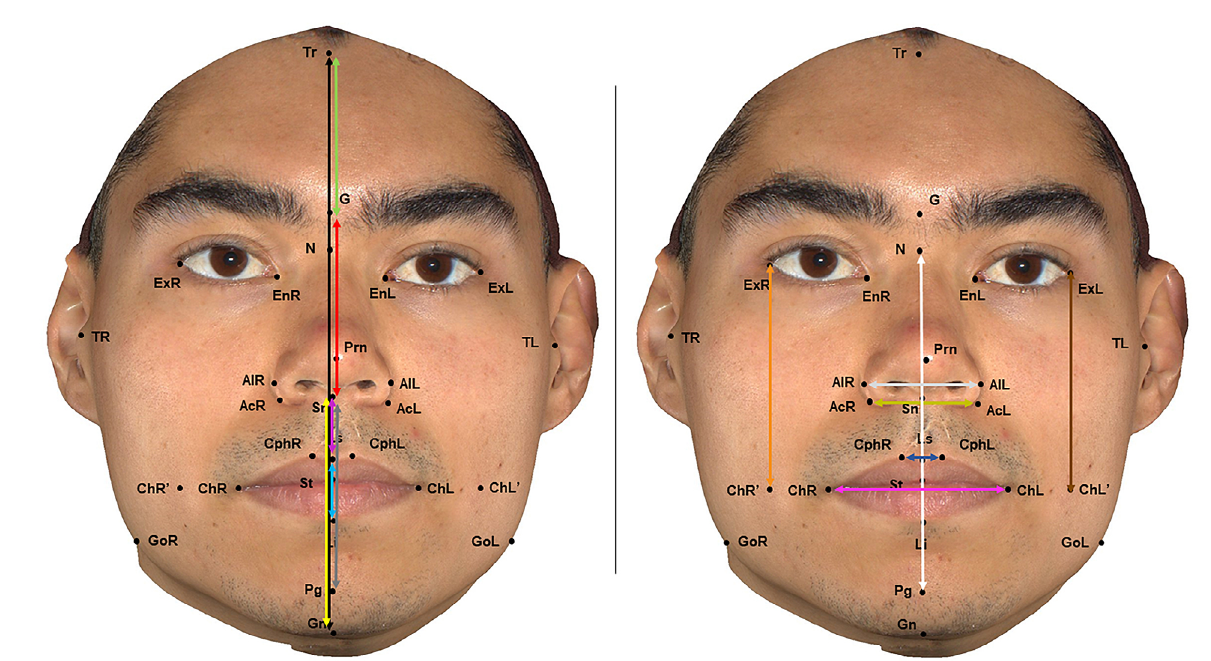
Figure 2- Linear measures obtained with the Vectra Analysis Module software (VAM elaboration, Canfield Scientific Inc.). Vertical lines – black: total facial height; green: upper third of the face; red: middle third of the face; yellow: lower third of the face; gray: anterior lower facial height; orange: distance between the exocanthion and the right cheilion; brown: distance between the exocanthion and the left cheilion; white: middle facial height. Horizontal lines – gold: width of the alar base; silver: width of the nose; navy-blue: width of the philtrum, and pink: mouth width